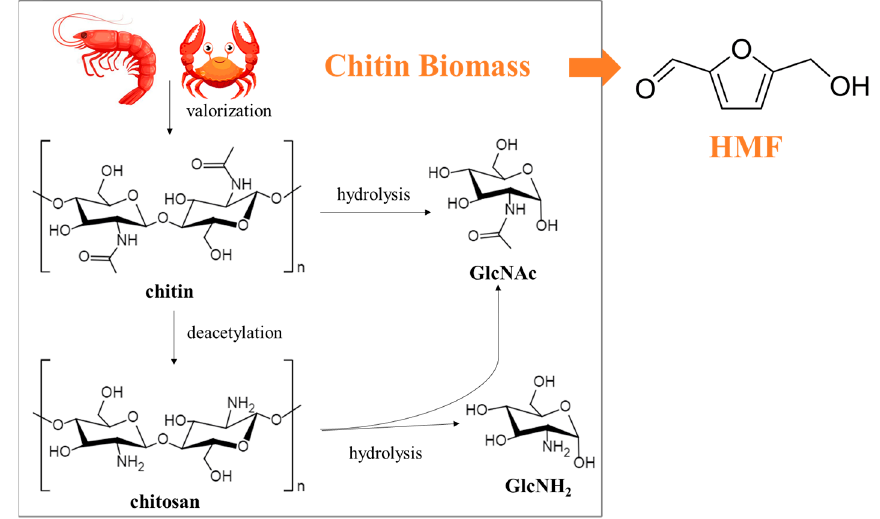
Figure 3. Production of HMF from chitin biomass.